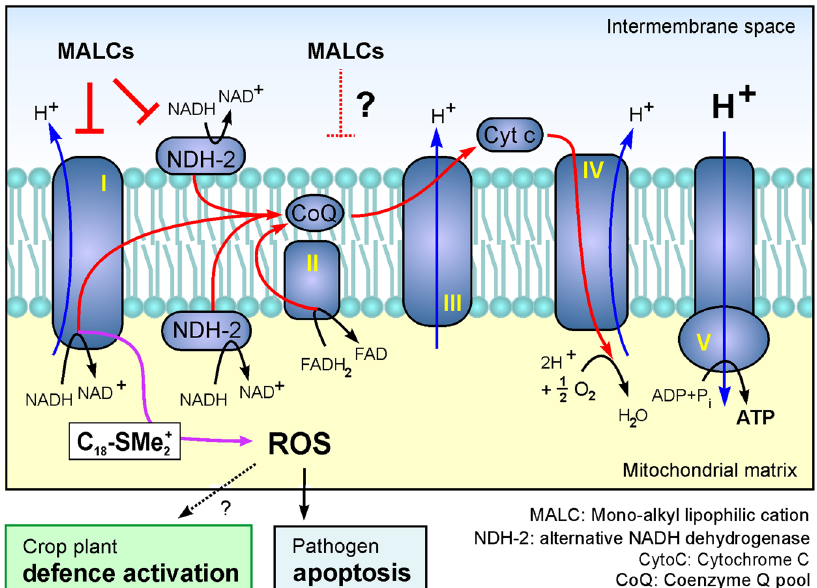
Fig. 9 Model of the effect of MALCs on fungal oxidative phosphorylation. Our results from several assays indicate that all MALCs inhibit oxidative phosphorylation. This could be a consequence of MALC insertion into the inner membrane, followed by inhibition of NADH oxidation and electron transfer through the electron transport chain. NADH oxidation in fungi involves unique enzymes (alternative NADH dehydrogenases, indicated by NDH-2) and respiratory complex I, which contains fungal-speci fi c subunits. Thus, the higher toxicity of MALCs to fungi may be linked to an activity on these fungal- speci fi c compounds. However, additional effects on IMM fl uidity and organization of the respiration complexes cannot be excluded (indicated by “ ? ” ). In addition, C 18 -SMe 2 + induces mROS production at complex I, suggesting that it may bind to or interact with this enzyme complex. Aggressive mROS damages lipids and proteins in the inner membrane, but also activates apoptosis in the pathogen cell. Moreover, C 18 -SMe 2 + -induced mROS production may participate in a mild activation of the plant defense system, evidenced by a slight oxidative burst 6 h post-treatment in rice